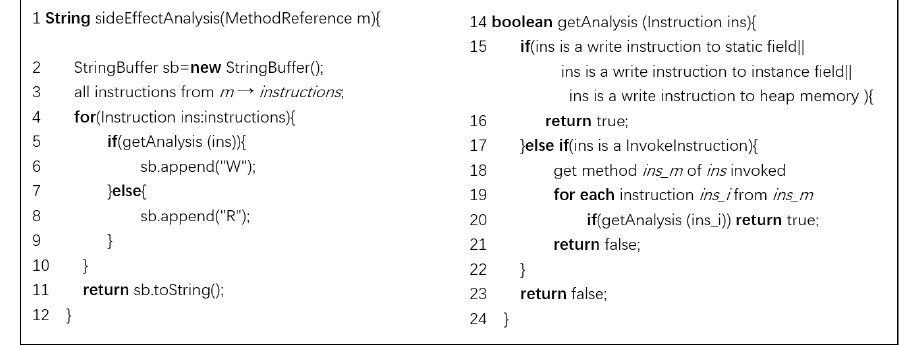
Figure 6. Algorithm for side-effect analysis